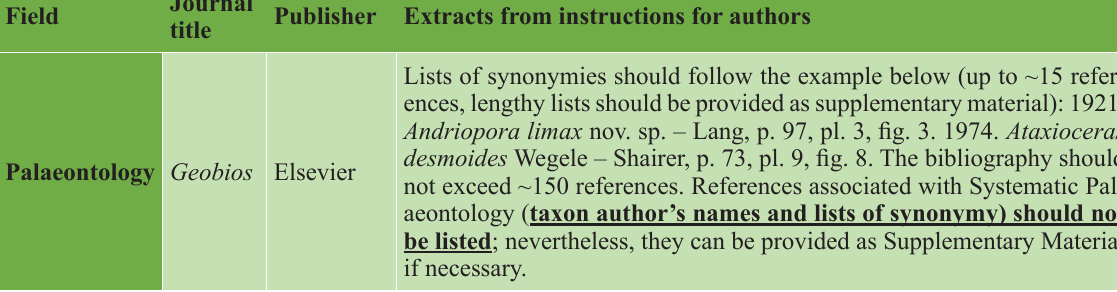
Table 2. Samples of journals studied with extracts of their instructions for authors concerning authorship citation. Group 2: Cited but not referenced.